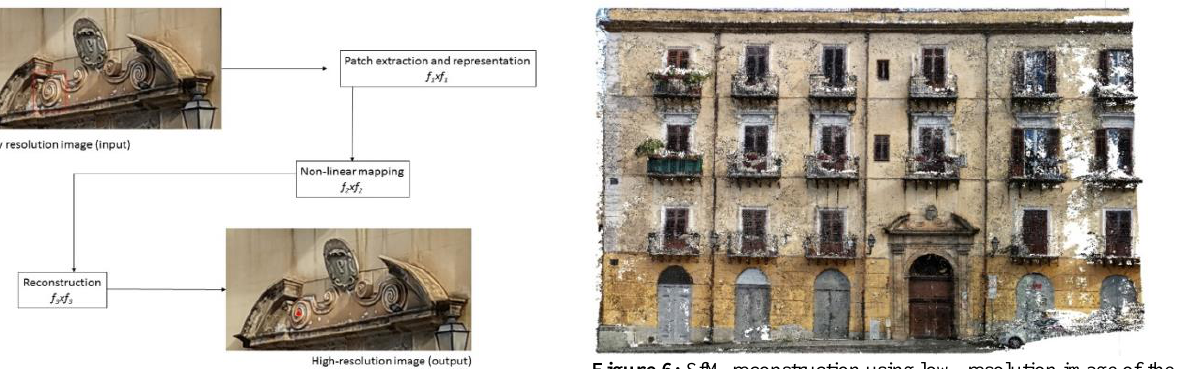
Figure 6: SfM reconstruction using low- resolution image of the façade of the ancient building. Dense Cloud.